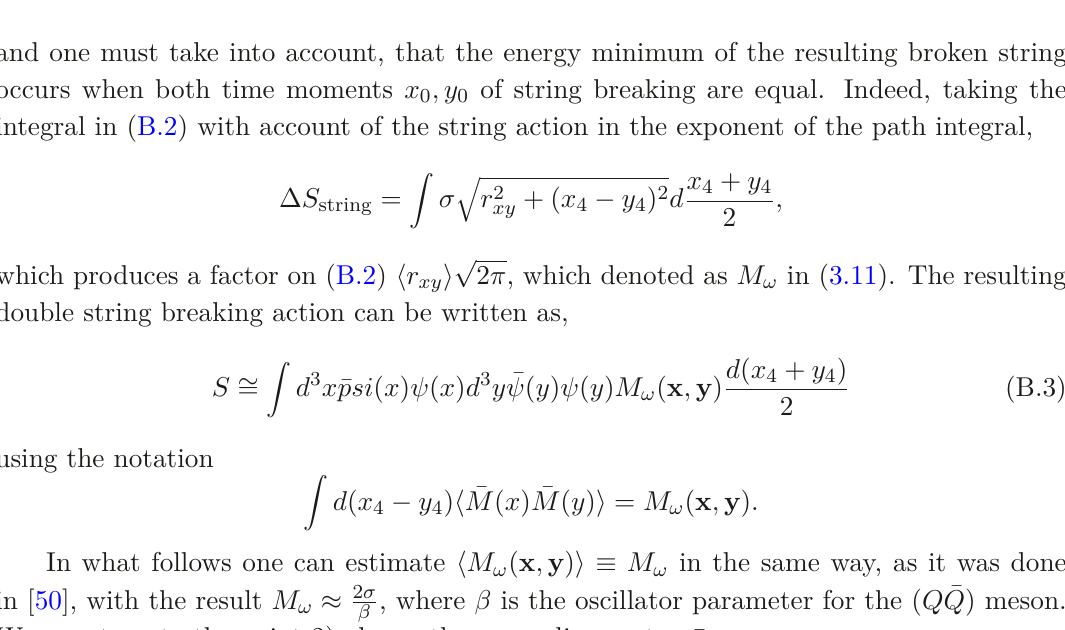
Table 5 . Average values of quark and antiquark kinetic energies in different